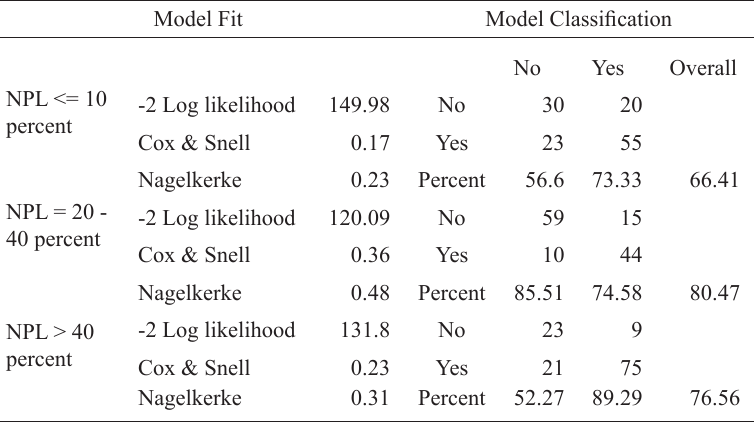
Determinants of the Different Levels of PLR (LOW) Models Summary Model Fit Model